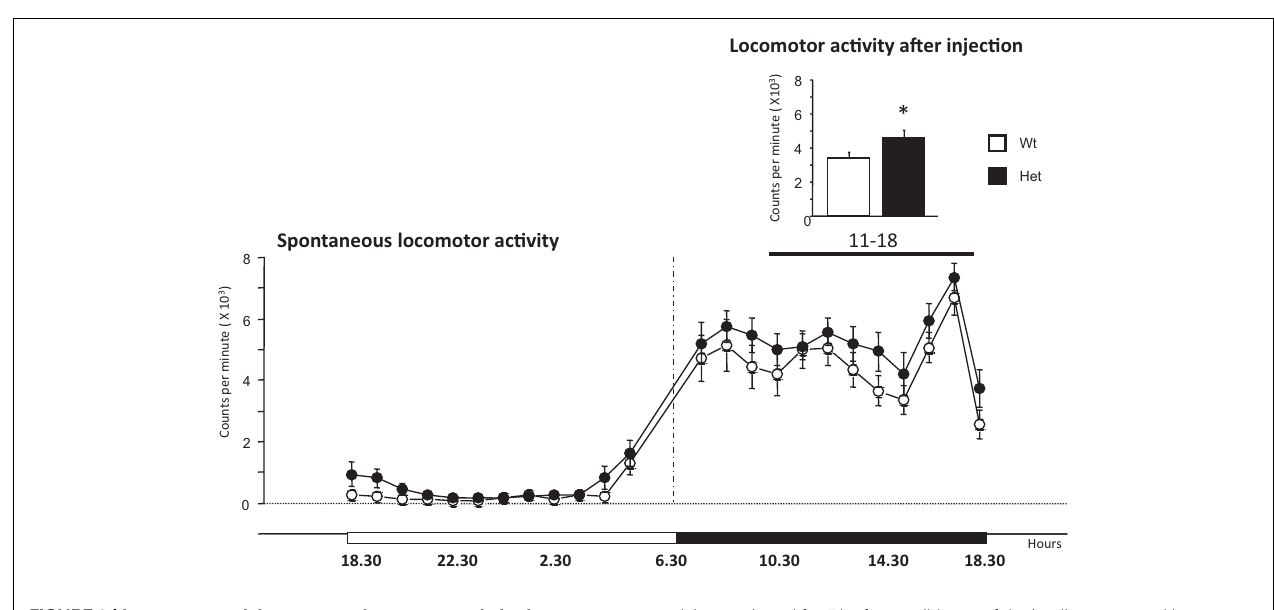
FIGURE 3 | Locomotor activity expressed spontaneously in the home-cage by 6-month-old wildtype and heterozygous reeler male mice .The main graph indicates spontaneous locomotor activity monitored for 1week.The graph on the top right shows the spontaneous locomotor